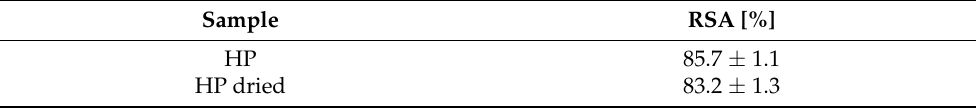
Table 5. Radical scavenging activity (RSA%) of not dried (HP) and dried (HP dried) hazelnut perisperm